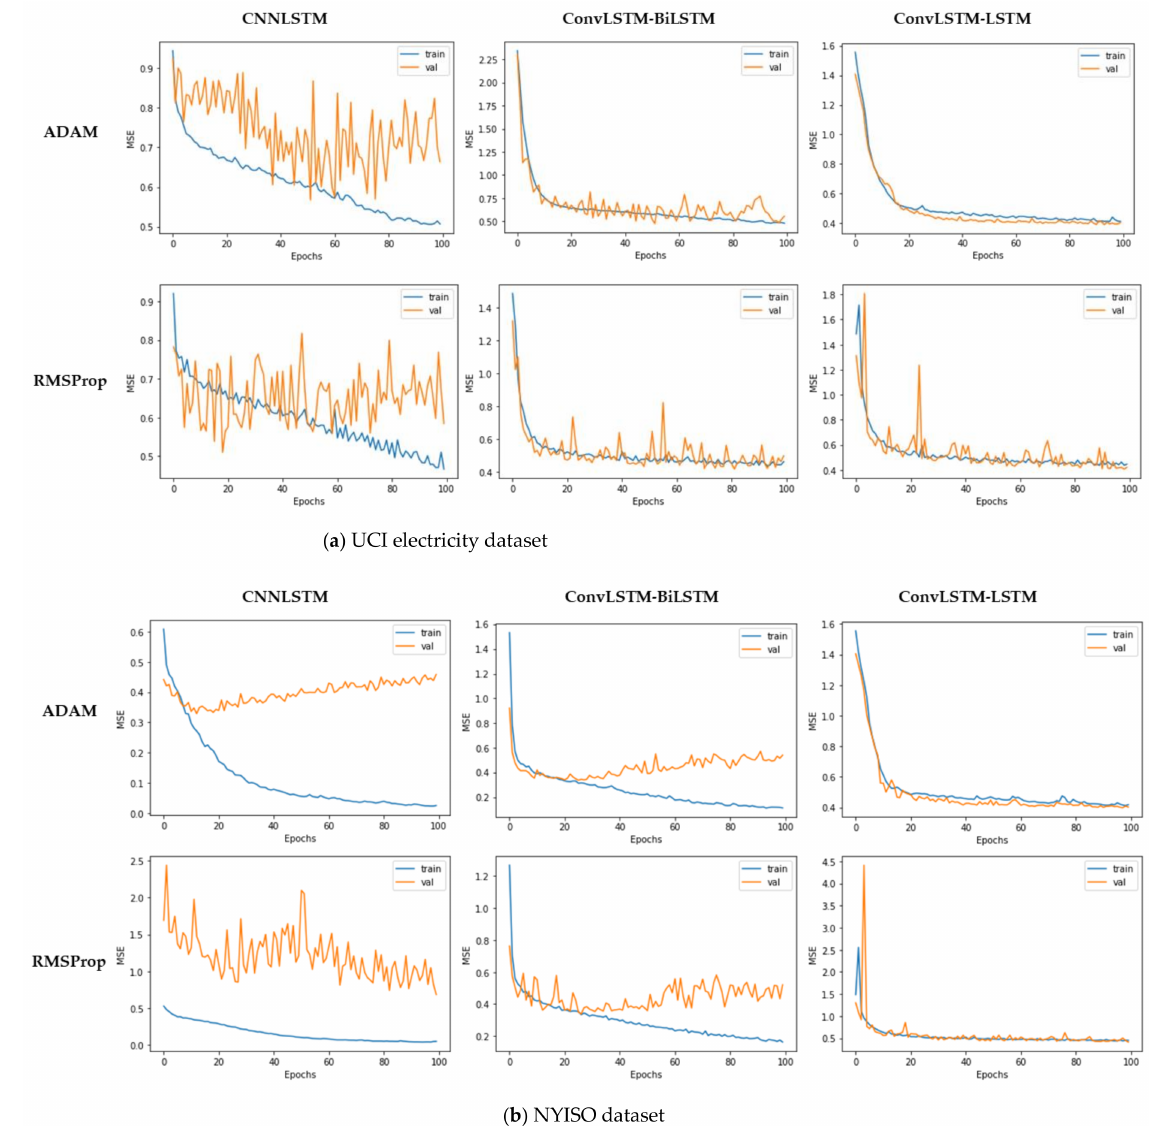
Figure 11. Illustration of training loss and validation loss using different optimizers for both datasets, ( a ) UCI electricity dataset, and ( b ) NYISO